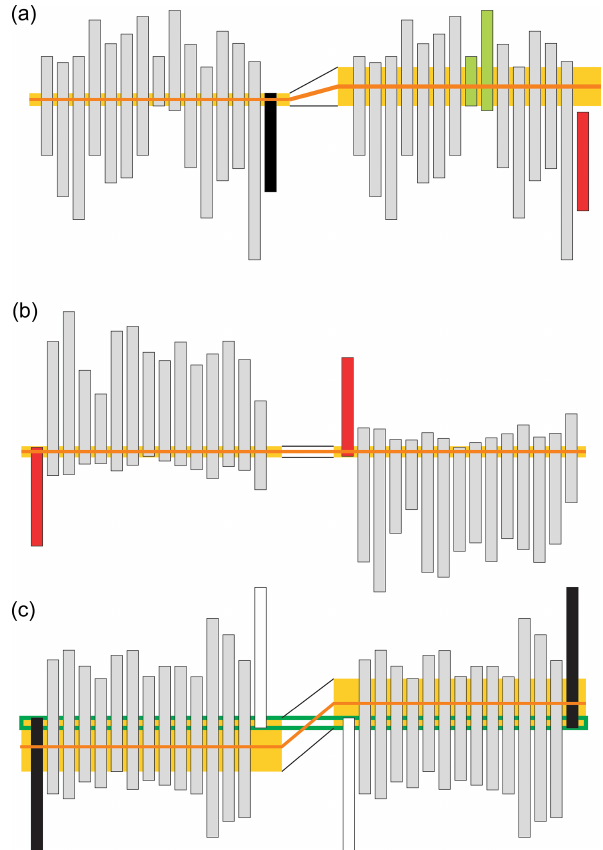
Figure 6. Logical inconsistencies in the application and theory of the Coexistence Approach. Shown are coexistence intervals (orange bars) based on slightly (a, c) or extremely (b) different sets of near- est living relatives (NLRs). Panel (a) : use of the centre value to de- termine climate shifts. A single NLR (black) is replaced by an NLR tolerant to lower values (red), which would be eliminated as a cli- matic outlier by the two green NLRs, thus leading to a higher centre value. Panel (b) : all NLRs have contrasting climate tolerances, the exotic taxa in both floras (red) ensure that the reconstructed coex- istence interval is the same. Panel (c) : two floras that only differ by the absence (white bars) or presence (black bars) of two taxa. The resulting coexistence intervals would be interpreted as a shift towards higher values. The dark green box shows the coexistence interval of a flora in which both taxa are represented.